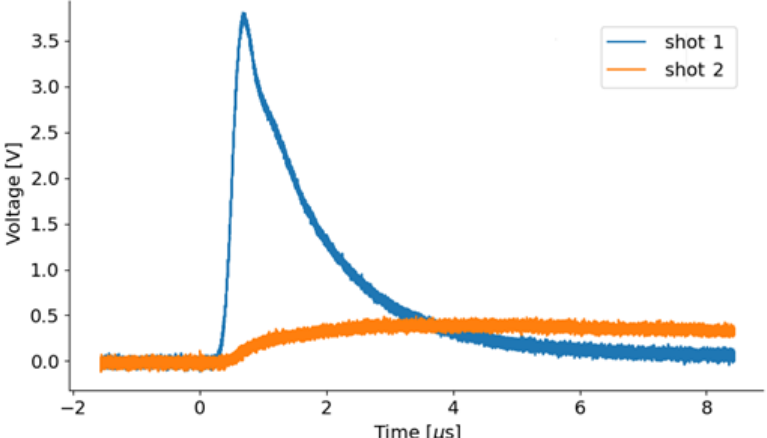
Figure 3. TOF data that were obtained from PERLA 1 kHz laser at intensities of 2.2 × 10 16 W/cm 2 with 2 mm thickness Cu target. Shots 1 and 2 gathered data using the same laser intensity and target parameter specifications under different laser focal sizes due to consecutive laser-target collisions. The X -axis has been adjusted to allow the photopeak to lie on the zero-line for each shot, respec- tively.